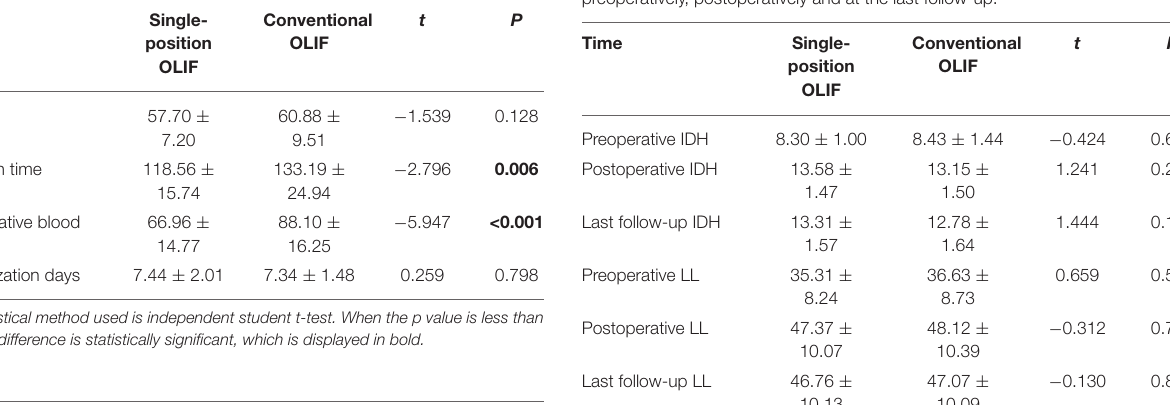
Conventional position OLIF OLIF